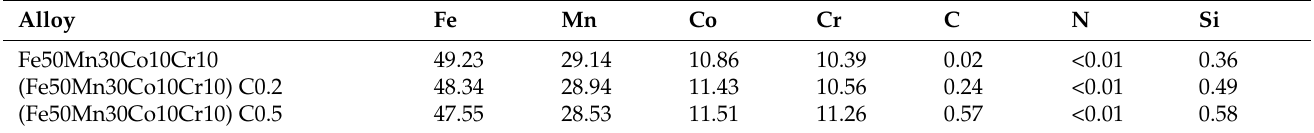
Table 3. Specimens and corresponding treatment processes (C